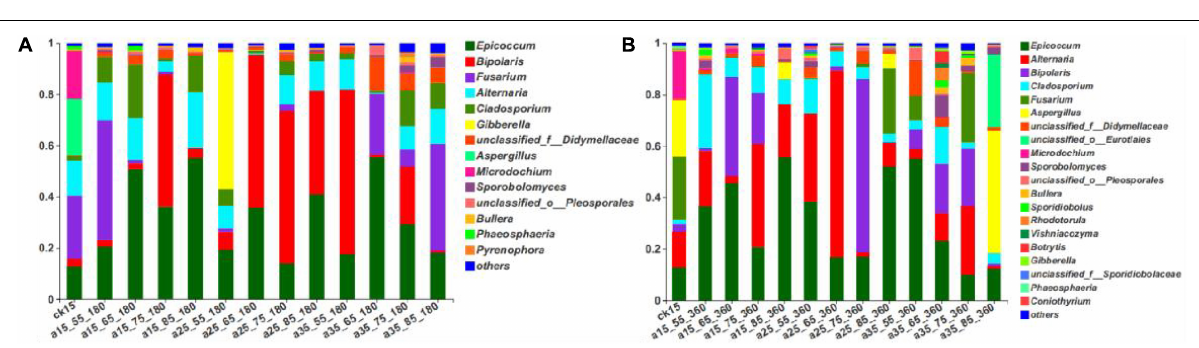
FIGURE 3 | The relative abundance of fungal community genus levels in barley after storage for 180 days (A) vs. 360 days (B) . The relative abundance of each taxon was defined as the percentage of the same taxon relative to the corresponding total sequences for each sample. The species with relative abundance ratios < 1% were classified as